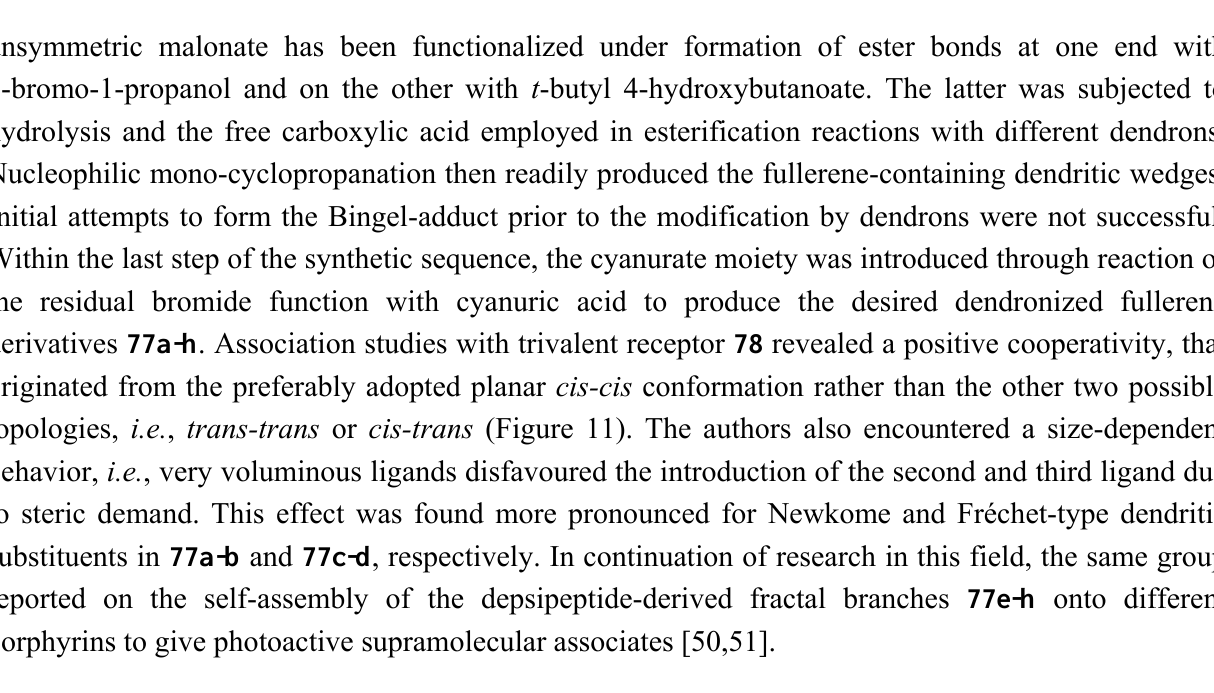
Figure 11. Supramolecular assemblies of monodendronized fullerene derivatives 77a-h onto Hamilton-receptor functionalized host molecule 78